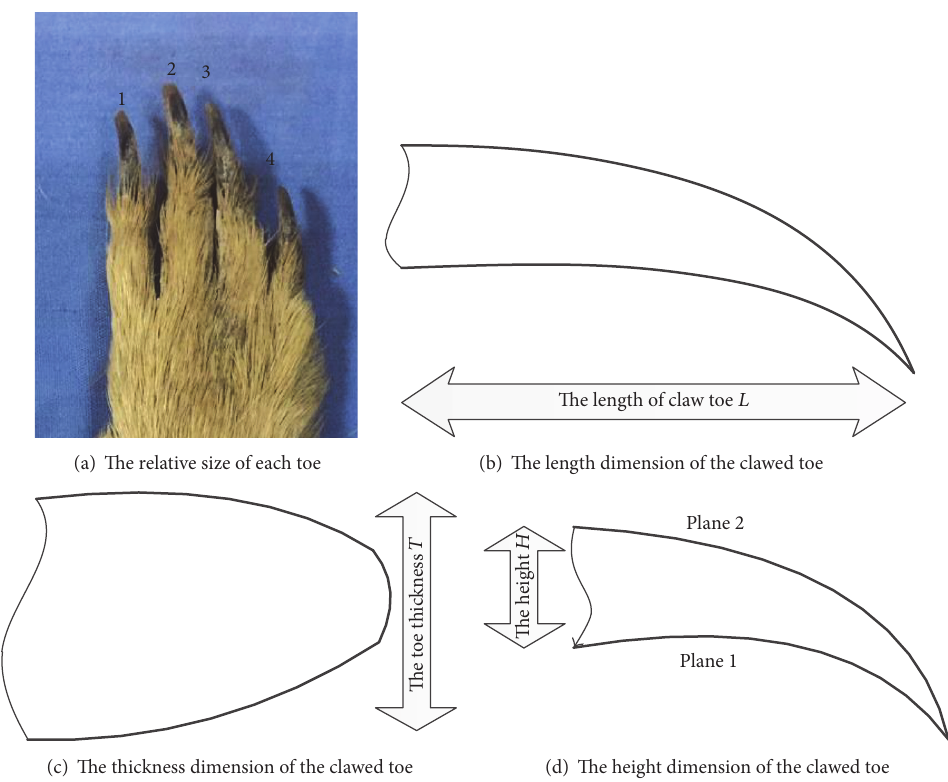
Figure 1: Geometrical dimensions of Himalayan marmot clawed